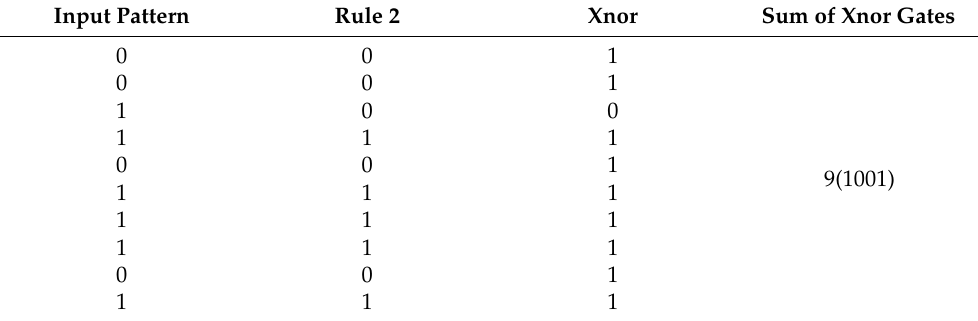
Table 2. The similarity of patterns.